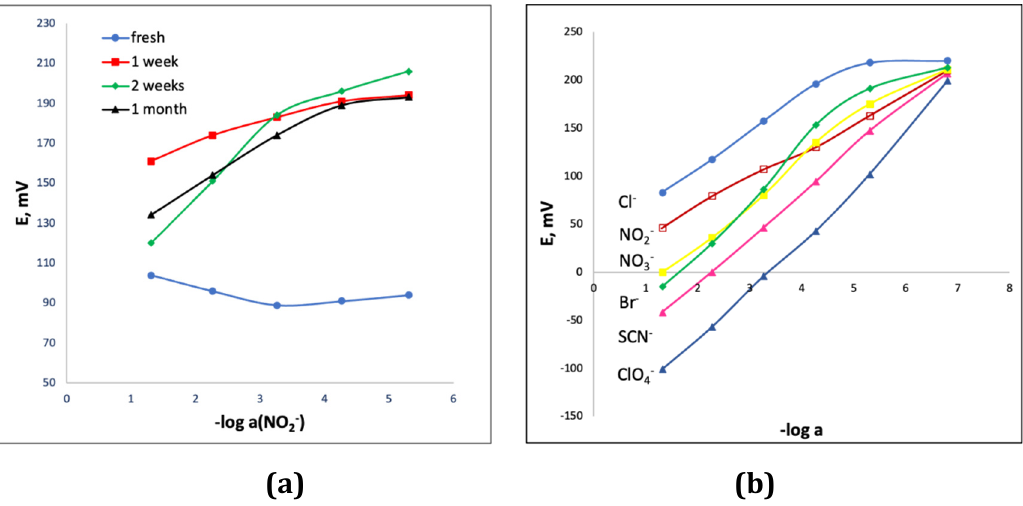
Figure 6. Calibration curves of CoTPP-N-based ( a ) membrane Mb4 doped with 80 mol% of TpClPBK in NaNO 2 solutions over one-month period of continuous tests; ( b ) membrane Mb3 containing CoTPP-N and 20 mol% of TpClPBK in sodium salts of several anions. Measurements were performed in MES buffer background, pH 5.5.